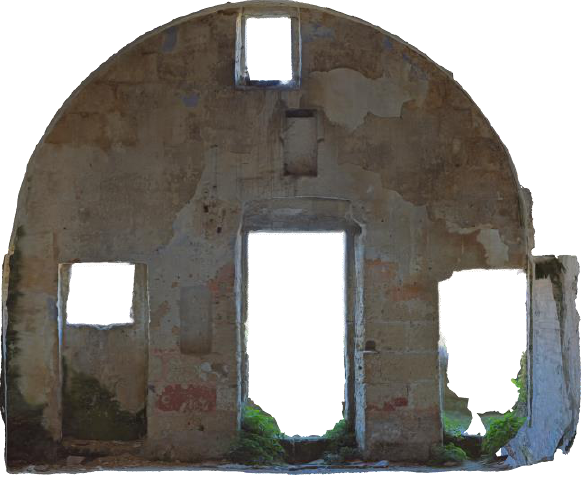
Figure 10. Orthophoto of the interior